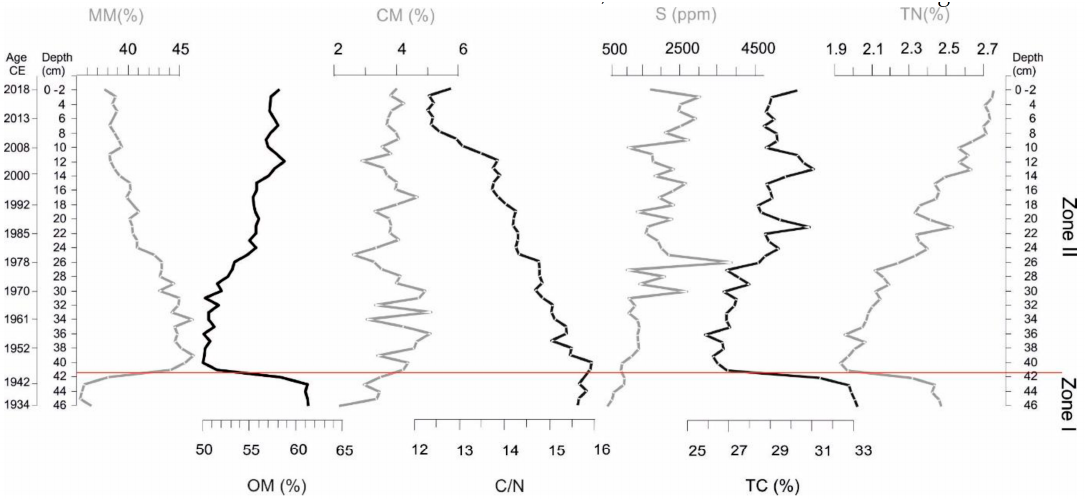
Figure 4. Lake Sekšu Sediment composition: minerogenic matter (MM), organic matter (OM), carbonate matter (CM), C / N expressed as atomic ratio, sulfur (S), carbon (TC), nitrogen (TN), and the division in two zones based on major changes in sedimentary composition.